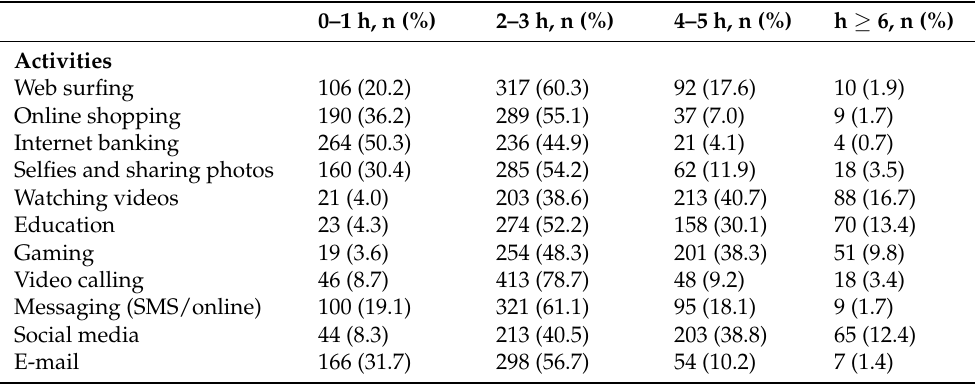
Table 6. Aim and daily recurrent of technology use (Hours) (n =